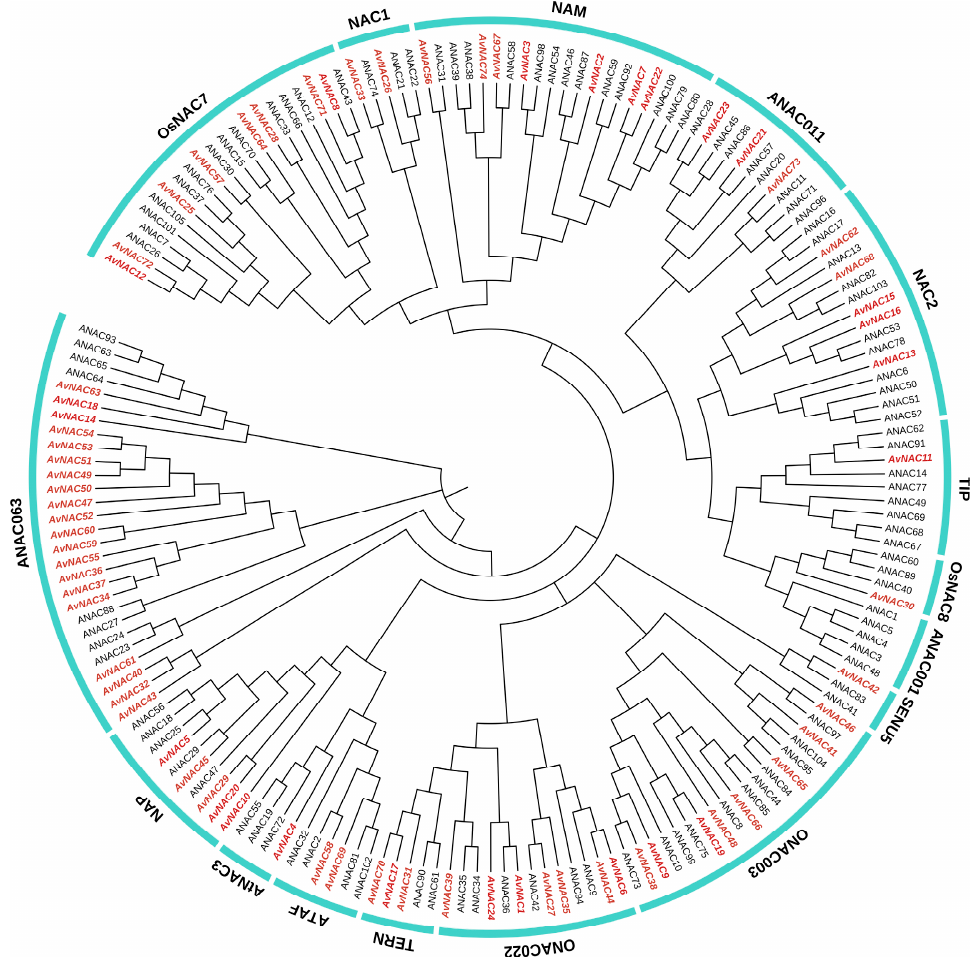
Figure 4. The phylogenetic tree of AvNAC proteins with AtNAC proteins in A. thaliana . The AvNACs are indicated by red color and italic, and the AtNACs are indicated by black color.